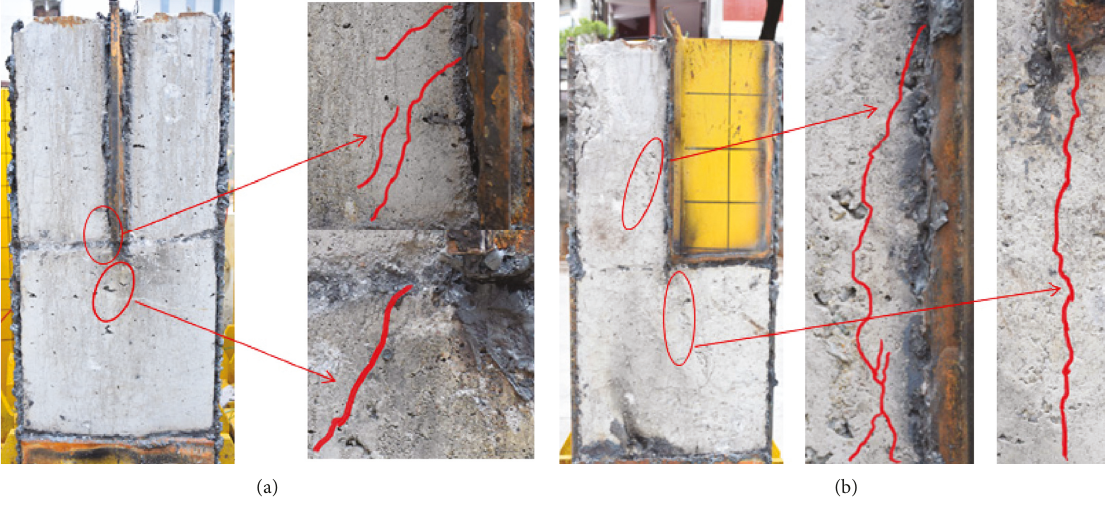
Figure 6: Damage in core concrete: (a) SJ1-1; (b) SJ1-4.